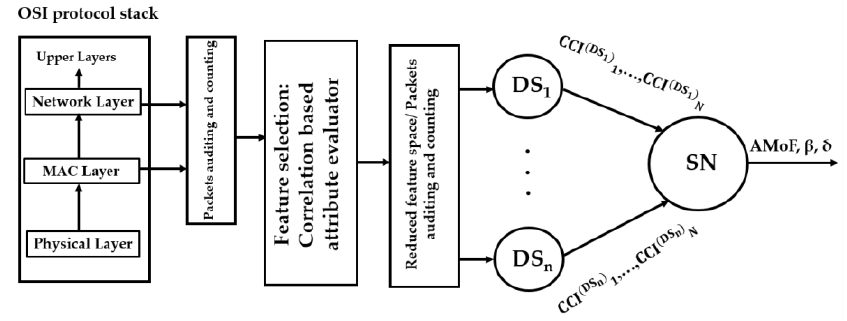
Figure 1. A two stage cross layer IDS.